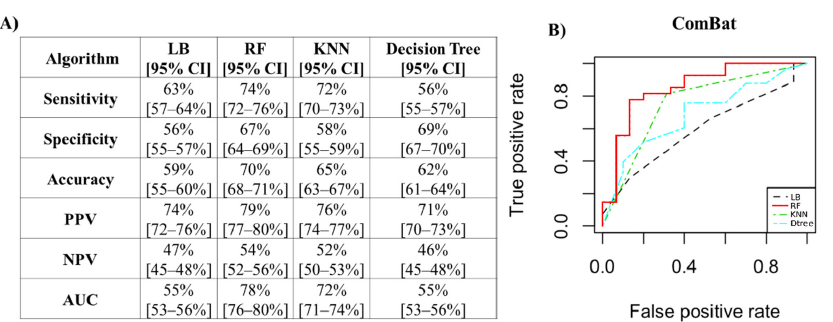
Figure 7. Performance measures to classify patients with positive biopsies for the ComBat method. ( A ) Algorithm performance via PCs to classify patients with positive biopsies for the ComBat method. ( B ) ROC curves of the four classifiers. PPV: positive predictive value; NPV: negative predictive value; AUC: area under the curve; LB: LogitBoost; RF: random forest; KNN: k-nearest neighbors; CI: confidence interval.